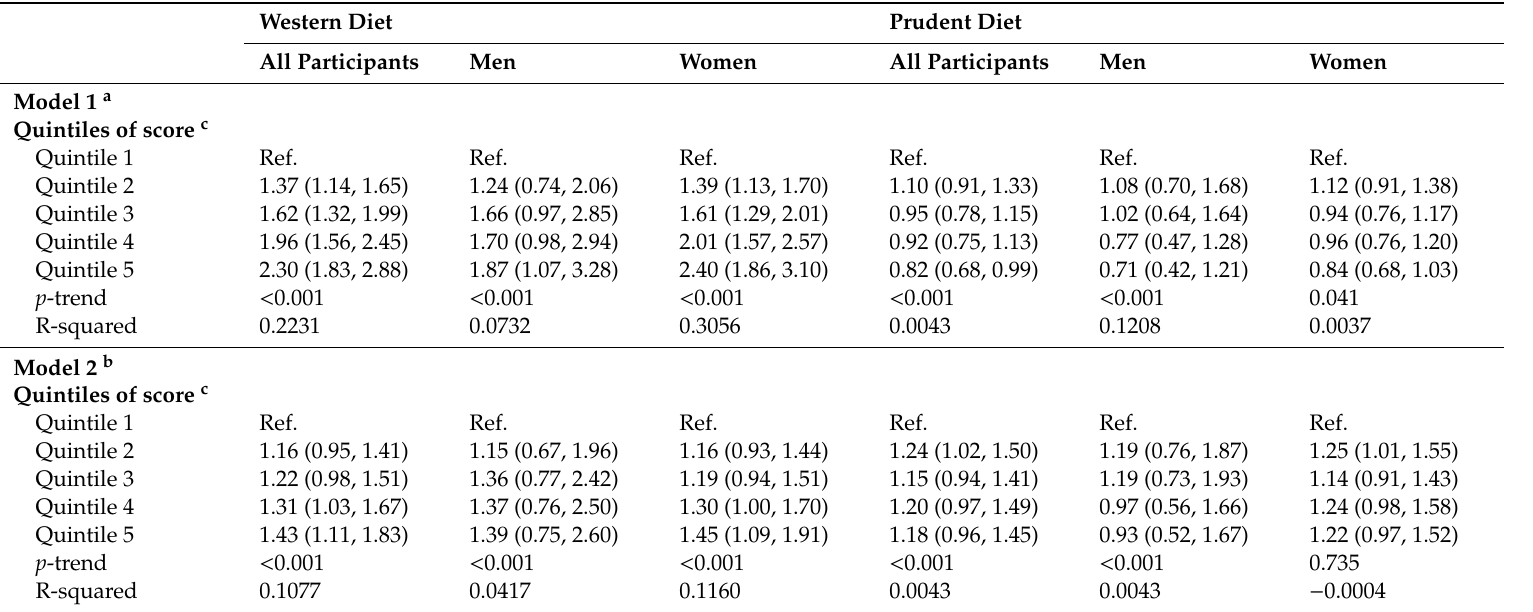
Table 2. Odds of overweight / obesity according to adherence to the Western and Prudent diet among men and